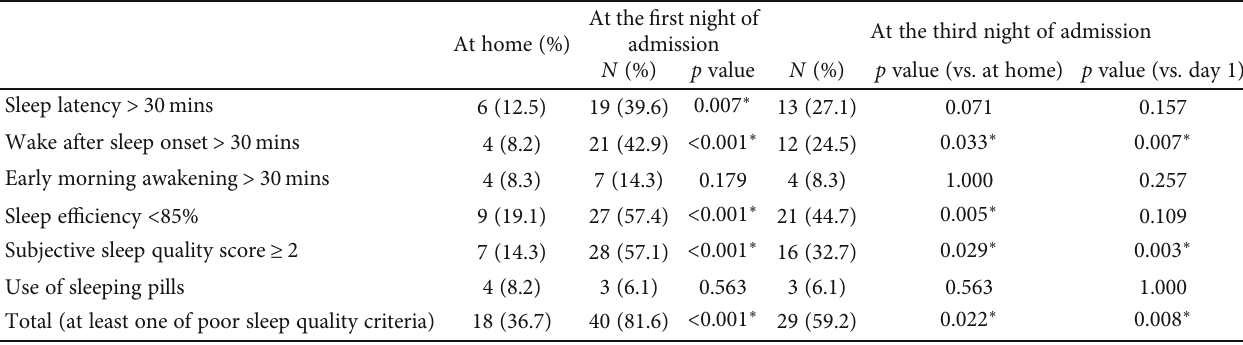
Table 3: Prevalence of poor sleep quality (ordinary ward).